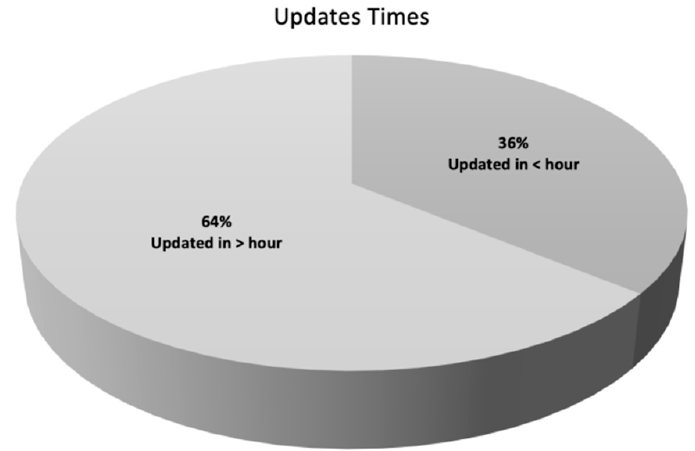
Figure 2. Distribution of update times (percentages).